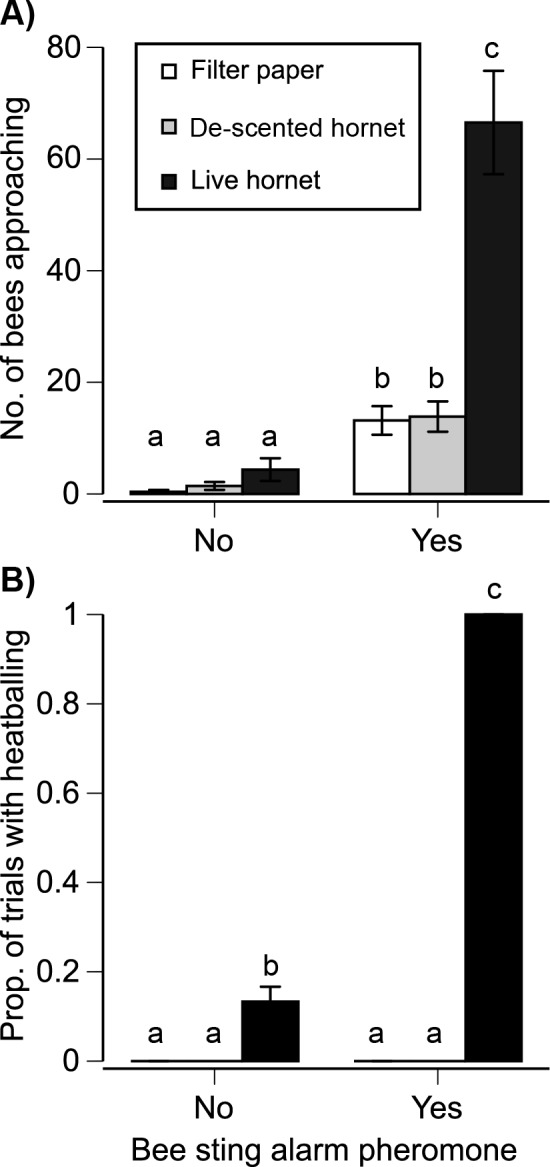
Stimuli that elicit (A) approaches to and (B) heat-balling of the small hornet (V. velutina). The alarm pheromone (one bee sting equivalent) was presented at the beginning of each trial (ten trials/colony for 30 total trials). Graphs show the mean ± 1 standard error: 100% of live hornets presented with honey bee sting alarm pheromone were heat-balled (0 standard error for this treatment). Different letters indicate significant differences (Tukey’s HSD test, p < 0.05).